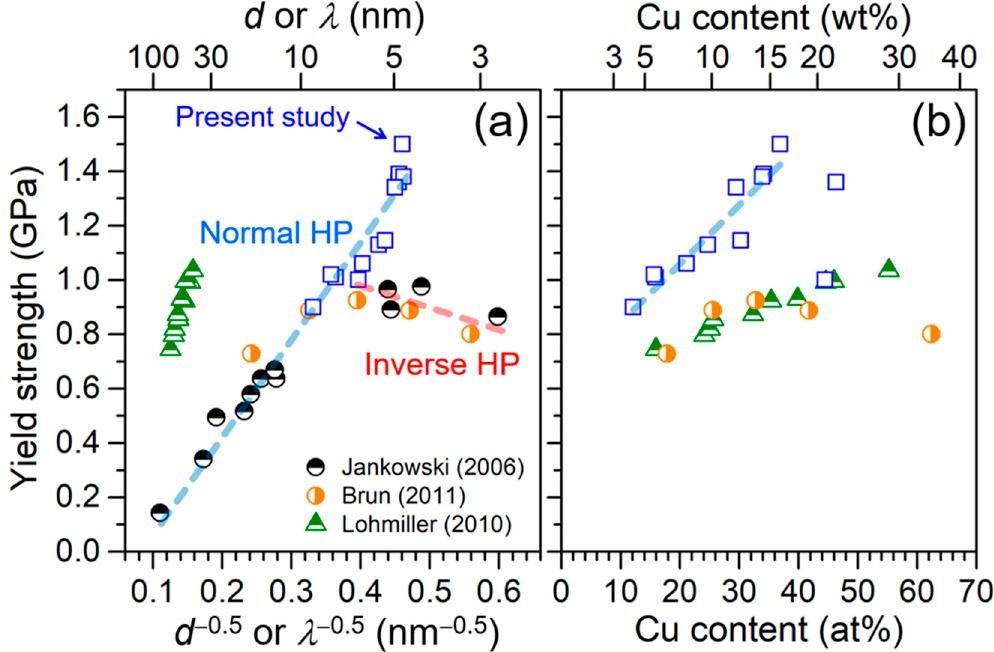
Figure 4. ( a ) Hall–Petch plot of Au–Cu alloys. The yield strengths in the literatures were converted from Vickers hardness. ( b ) A plot of yield strengths as a function of Cu content. from Vickers hardness. ( b ) A plot of yield strengths as a function of Cu